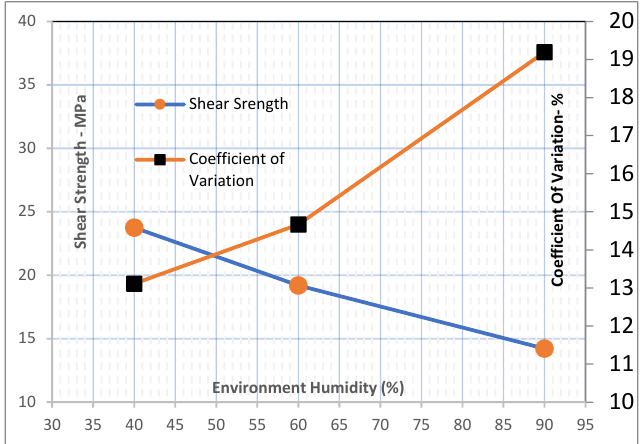
Figure 7. Change of shear strength by environmental humidity. Shear tests were conducted on samples after 21 days of exposure, and the mean results are shown.